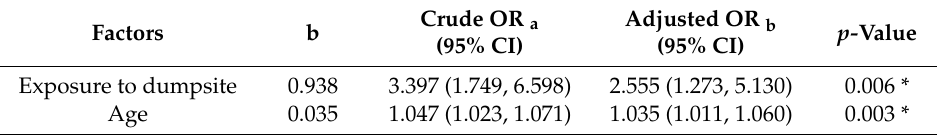
Table 6. The association between dumpsite exposure and hypertension.